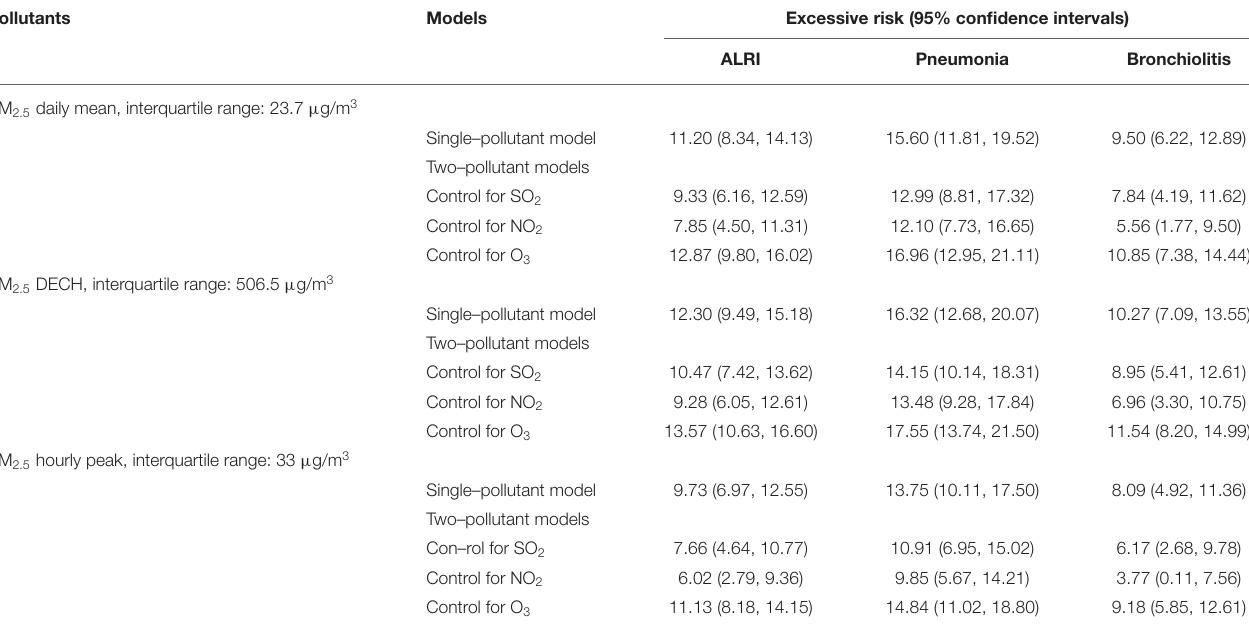
TABLE 2 | Excessive risk (95% confidence intervals) of outpatient visits of acute lower respiratory infection, pneumonia, and bronchiolitis per interquartile range increment in ambient PM 2.5 (daily mean, daily excessive concentration hours [DECH], and hourly peak) at lag03 using single–pollutant and two–pollutant